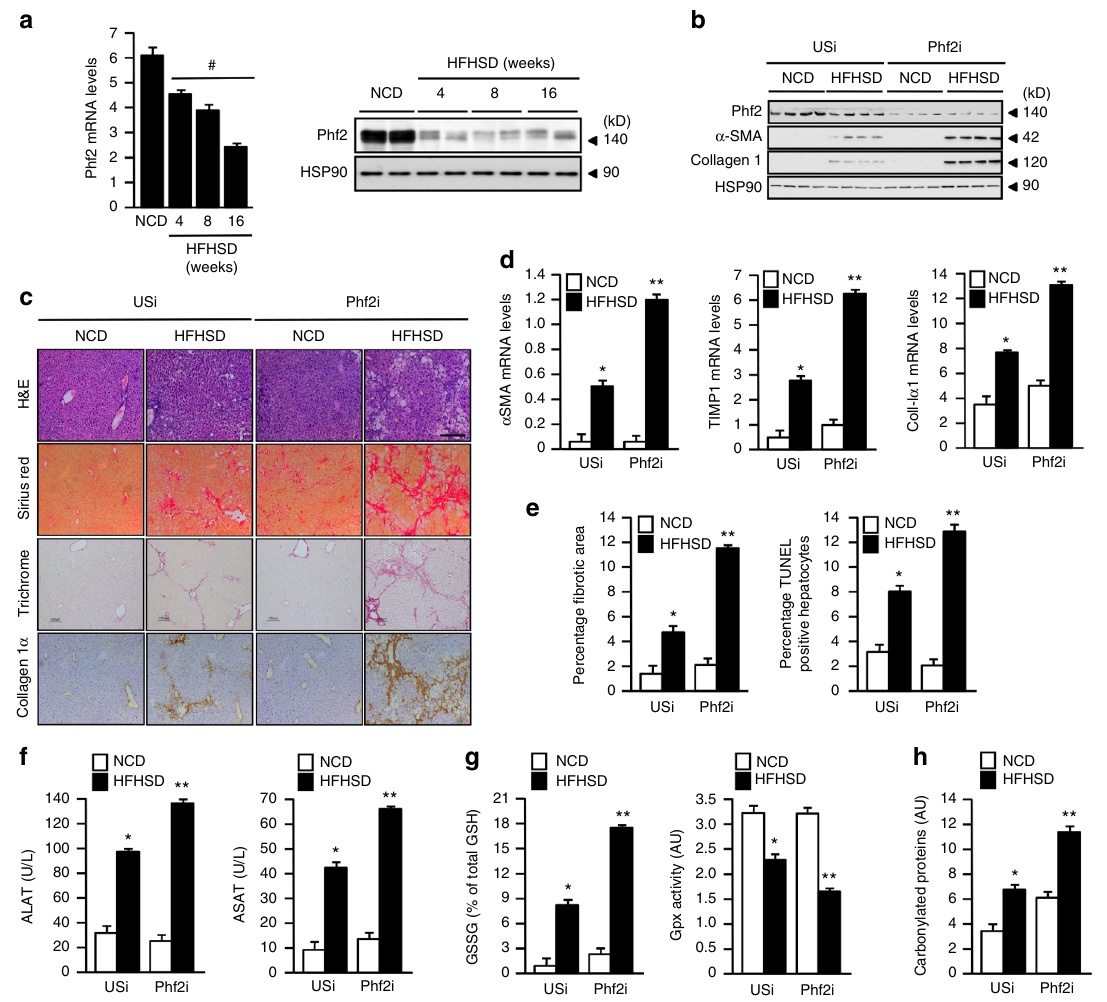
Fig. 7 Phf2 silencing favors liver fi brosis development upon HFHSD feeding. a Relative expression at the mRNA and protein levels of Phf2 in the liver of C57Bl6/J mice trough the time course of HFHSD feeding ( n = 8). b – h Phf2 expression was stably inhibited, through AAV strategy, speci fi cally in the liver of C57Bl/6J mice fed with either a normal chow diet (NCD) or with a high fat and high sucrose diet (HFHSD) for 16 weeks. Mice were then studied in the fed state. b Representative western blot analysis of α -SMA and collagen I in the liver of USi or Phf2i mice ( n = 12 per group). c Liver sections stained with hematoxylin and eosin (H&E), sirius red, trichrome masson and collagen I α are shown. Scale bars = 100 μ m ( n = 6 per group). d Expression of coll-Ia1, α - SMA and TIMP-1 ( n = 12 mice per group). e Percentage of fi brotic area and percentage of apoptotic hepatocytes ( n = 12 per group). f Circulating levels of ALAT and ASAT ( n = 12 per group). g Relative oxidized GSSG content and measurement of Gpx activity compared to USi ( n = 6). h Levels of carbonylated proteins ( n = 6 mice per group). All error bars represent mean ± SEM. Statistical analyses were made using Anova, followed by Bonferonni ’ s test. # P < 0.01 HFHSD compared to NCD, * P < 0.01 NCD/USi compared to HFHSD/USi, ** P < 0.01 HFHSD/Phf2i compared to